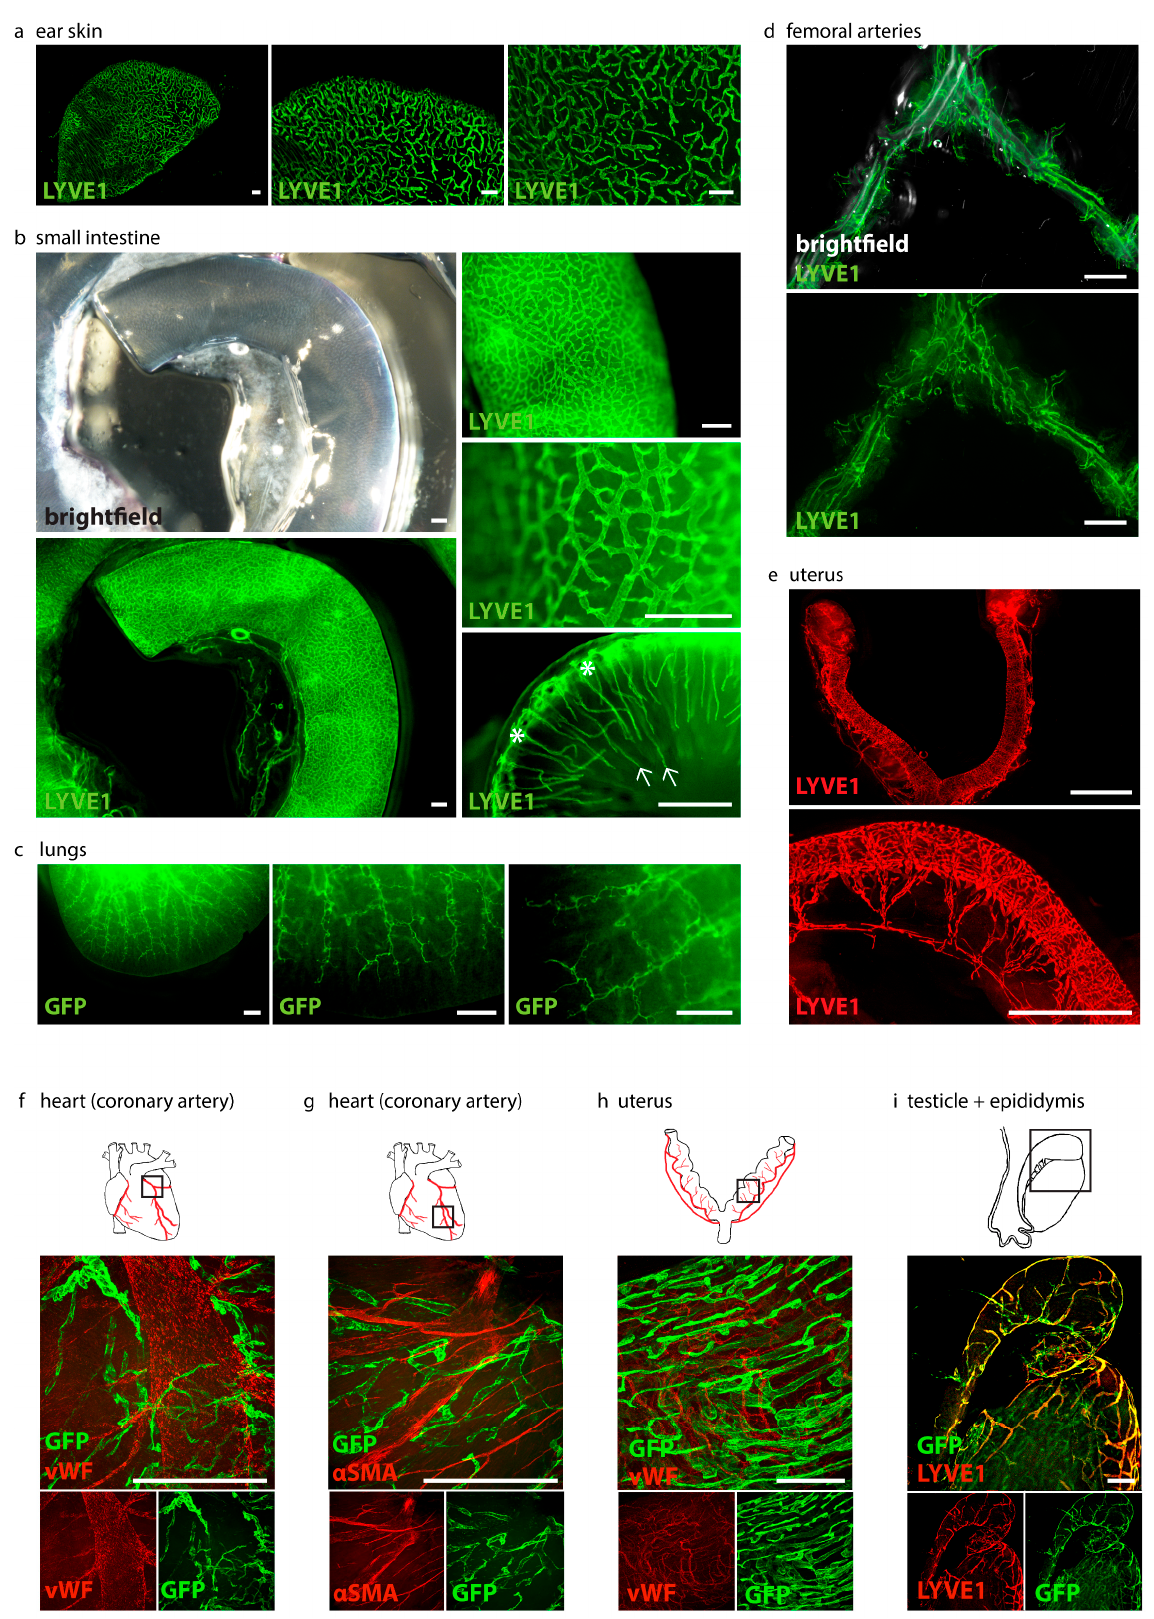
Figure 4. Visualization of organ-specific lymphatic vasculature. ( a ) Lymphatic vasculature of the ear skins of adult C57BL/6 mice. Samples were stained with anti-LYVE1. Pictures were taken with a stereo microscope, scale bar 500 µ m (n = 3 skin samples of 3 mice). ( b ) Lymphatic vasculature of the